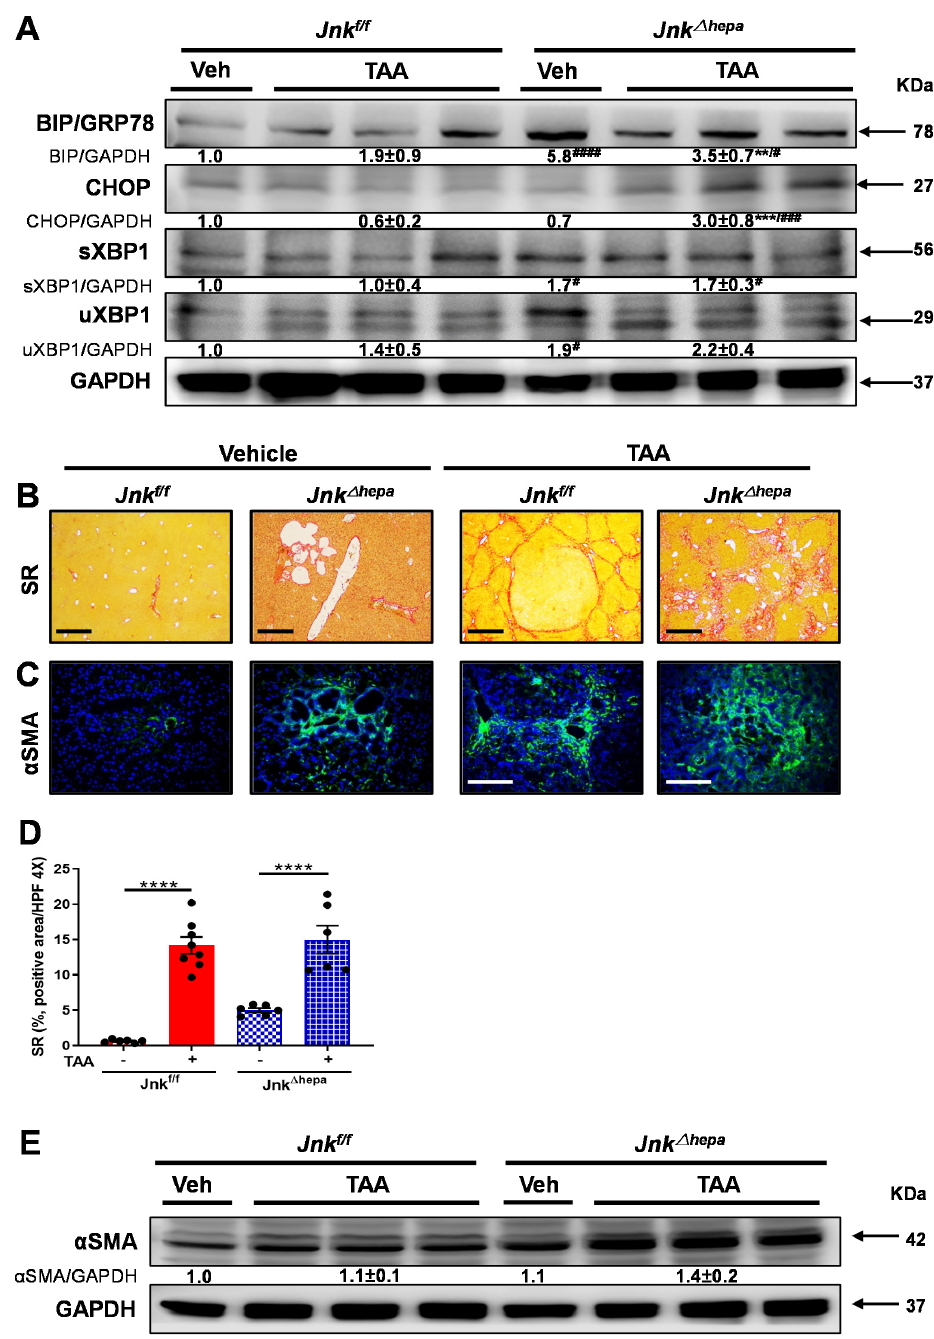
Figure 5. TAA challenge exacerbates liver fibrogenesis in mice with hepatocytic deletion of Jnk1/2 . ( A ) The expression of BiP/GRP78, CHOP, spliced XBP1 (sXBP1) and unspliced XBP1 (uXBP1) was evaluated in the livers of Jnk f/f and Jnk ∆ hepa mice treated or not with TAA using Western blot. Numbers denote molecular weight (KDa) of proteins. GAPDH served as loading control. ( B ) Representative Sirius Red (SR) stainings of liver paraffin sections from control and TAA-treated Jnk f/f and Jnk ∆ hepa mice ( n = 6-8 mice per group). Scale bars, 500 µ m. ( C ) Expression of α SMA protein was assessed via IF staining. Scale bars, 50 µ m. ( D ) Positive area of fibrosis was calculated by ImageJ with micropho- tographs of SR staining. Data were represented as the mean ± SEM and graphed. ( E ) Expression of α SMA was analyzed by Western blot in the indicated groups of mice. Numbers denote molecular weight (KDa) of proteins. GAPDH served as loading control. (# p < 0.05; ** p < 0.01; ***/### p < 0.001; ****/#### p <